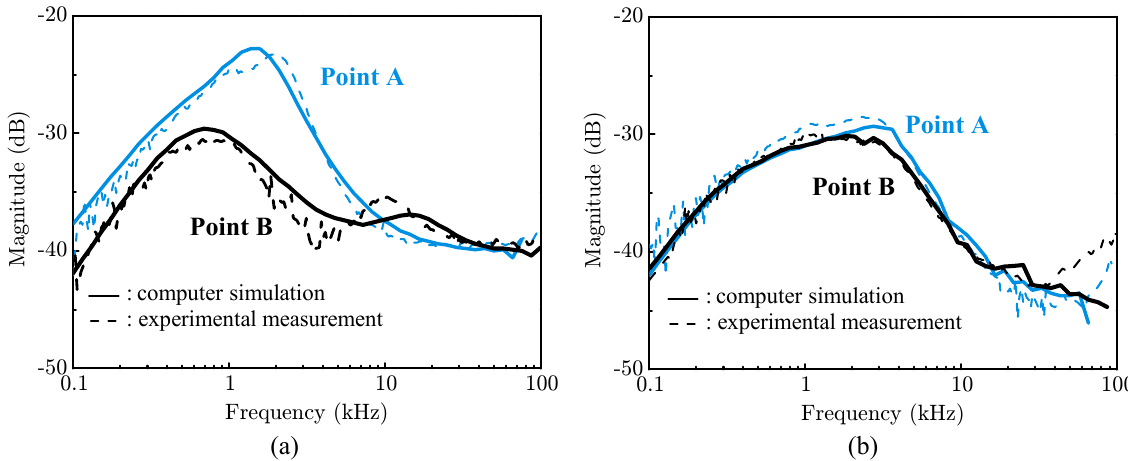
Figure 10. Output Impedance of voltage mode control and proposed current mode control. ( a ) Voltage mode control; ( b ) Current mode control.